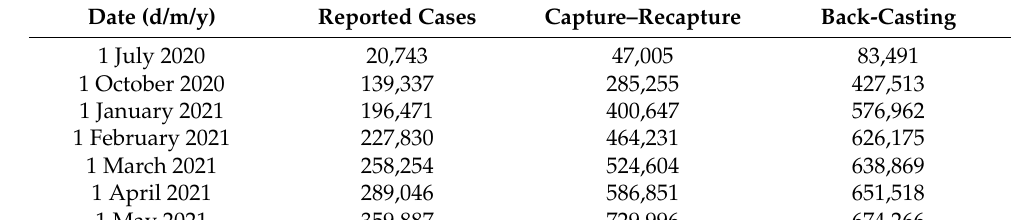
Table 1. Number of cases for some dates.